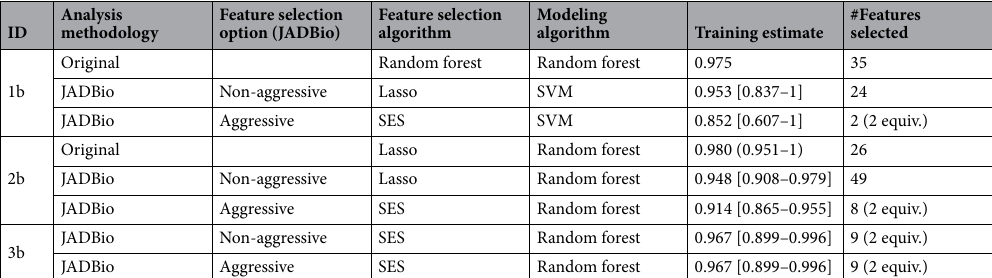
Table 3. Comparative evaluation of training performance estimates in terms of AUC on the full set of available data (training and validation). The notation is the same as in Table 2. (see Supplementary Table 1 for more results and links to the JADBio platform). In the case of 3a the same model was generated when either the aggressive or the non-aggressive feature selection option was